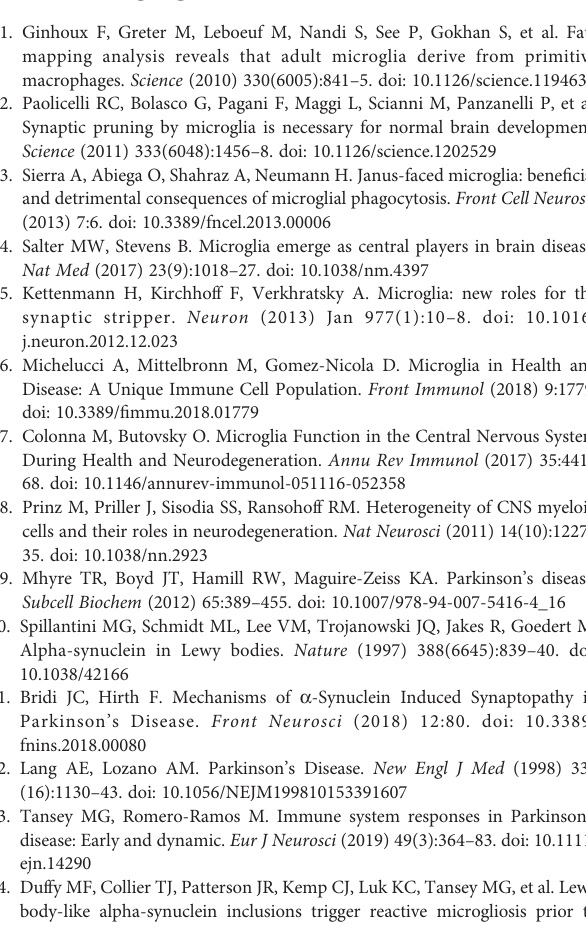
Supplementary Figure 1 | Cellular taxonomy across midbrain and striatum. (A) Heatmap showing clustering analysis featuring 15 most variable genes per cluster (FDR < 0.05). Colorbar represents z-scores (from low z-score in blue to high z-score in red). (B) t-SNE representation of cell-type representative genes. Color bar represents z-scores (high z-score in red).